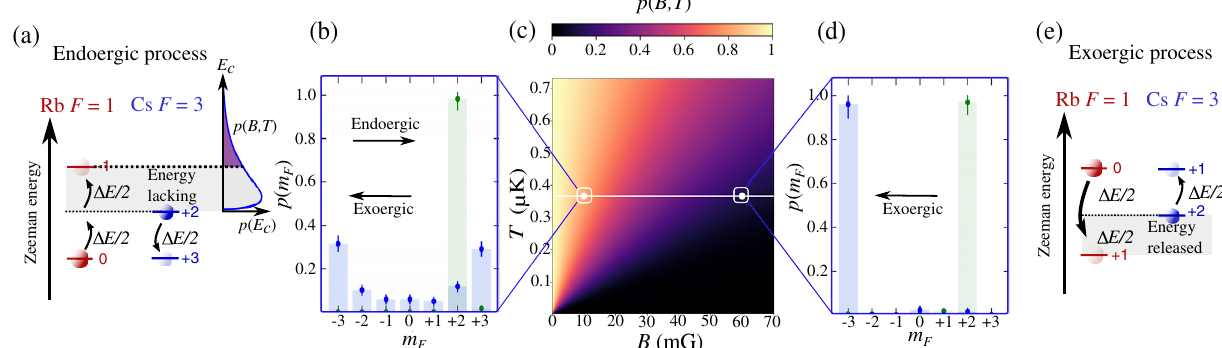
FIG. 2. Mechanism of motion-spin mapping onto quantum states. (a) Sketch of the endoergic process. Cs atoms go to a lower magnetic substate and release Δ E= 2 of energy, whereas Rb atoms go to a higher magnetic substate and require Δ E of energy. Therefore, this process can occur only if the missing Zeeman energy can be provided by kinetic energy E during the collision, which is only c possible for a fraction p ð B; T Þ of the probe atoms. (b) Experimental spin population of Cs atoms for a magnetic field of B ¼ 10 mG ¼ þ 3 before (green) and after 350-ms interaction time in a Rb bath at 366 þ 60 − 40 nK (blue). We measure a nonzero population in m F; Cs ¼ − 3 (exoergic SE). (c) Fraction of Cs atoms allowing to undergo an endoergic process as a function of the (endoergic SE) and m F; Cs magnetic field B , assuming a Maxwell-Boltzmann distribution at temperature T . The indicated values correspond to measurements in (b) p ð B; T Þ ¼ 0 . 8 and (d) p ð B; T Þ ¼ 0 . 1 . (d) Same as (b) but for B ¼ 60 mG. Here, exoergic processes dominate, yielding a measured ¼ − 3 . (e) Sketch of the exoergic process. Rb atoms are promoted to a lower magnetic state and population (in blue) of Cs atoms in m F; Cs release Δ E , while Cs atoms are left in a higher magnetic state and need only Δ E= 2 . As a consequence, this process has no energetic threshold and releases Δ E= 2 of energy into the